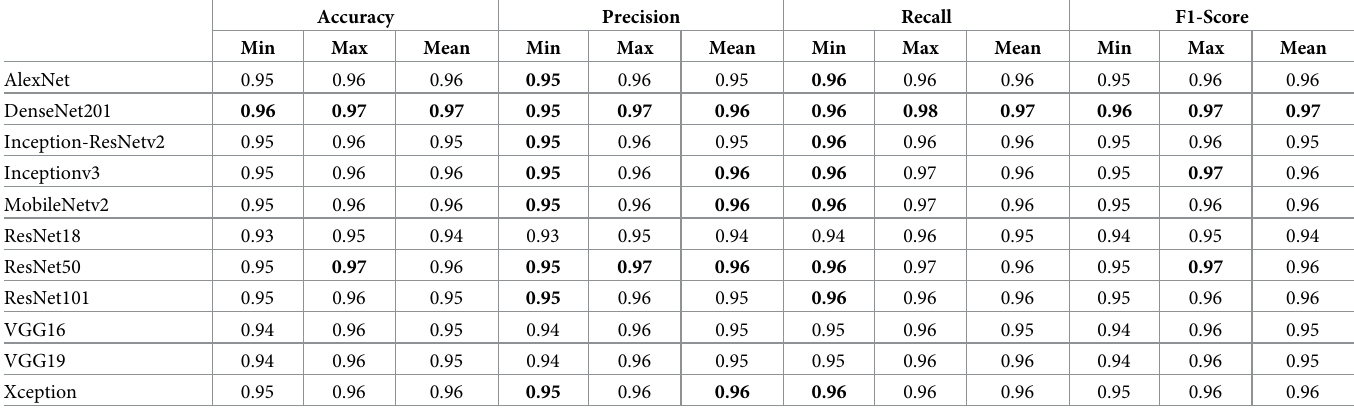
Table 17. Summary of classification performance of ML methods for each DCNN. Accuracy Precision